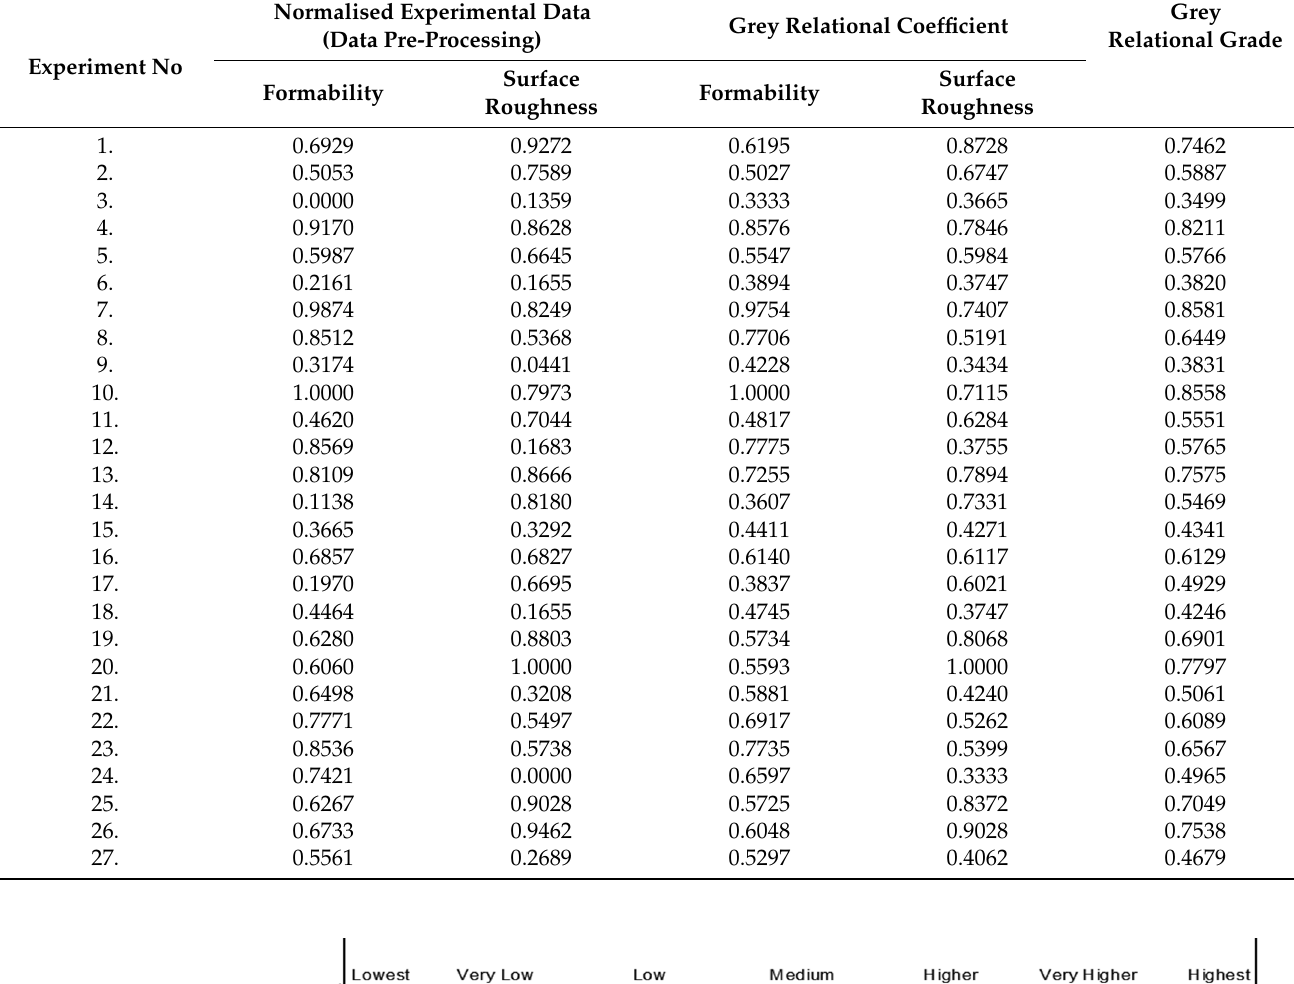
Table 5. Pre-processed data, grey relational coefficients, and grey relational grade AZ31.